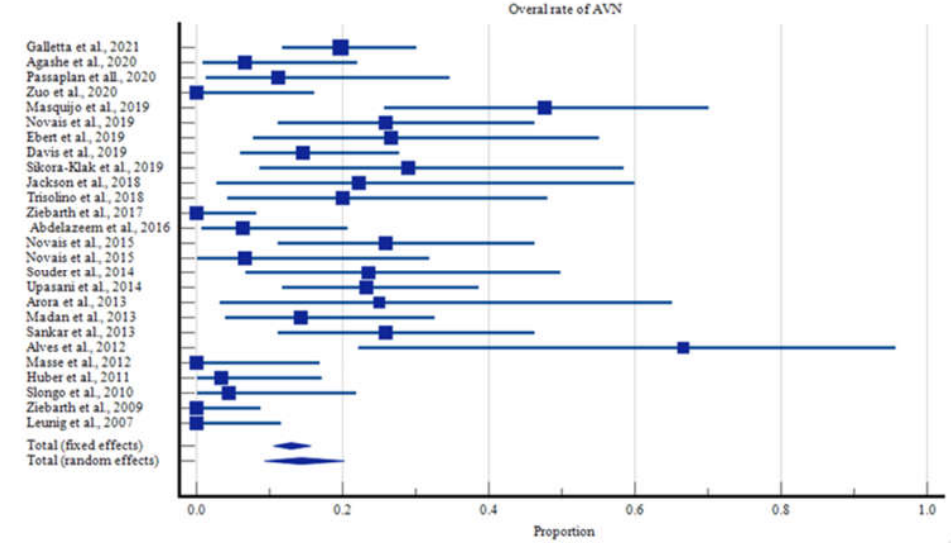
Figure 2. Overall rates of Avascular Necrosis.